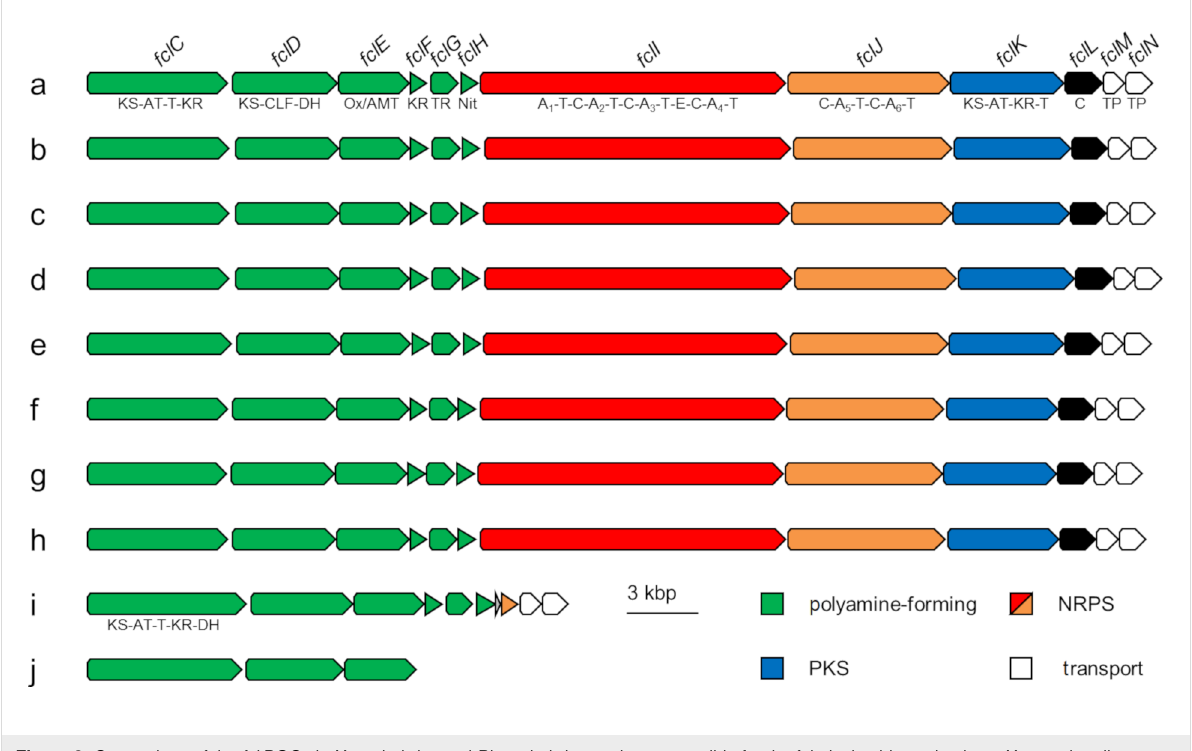
Figure 2: Comparison of the fcl BGCs in Xenorhabdus and Photorhabdus strains responsible for the fabclavine biosynthesis. a: X. szentirmaii , b: X. budapestensis , c: X. cabanillasii , d: X. indica , e: X. hominickii , f: X. stockiae , g: KK7.4, h: KJ12.1, i: X. bovienii , j: P. temperata . KS: ketosynthase, AT: acyltransferase, T: thiolation domain, KR: ketoreductase, CLF: chain length factor domain, DH: dehydratase, Ox: 2-nitropropane dioxygenase (enoyl reductase), AMT: aminotransferase, TR: thioester reductase, Nit: nitrilase, A: adenylation, C: condensation, E: epimerization, TP: